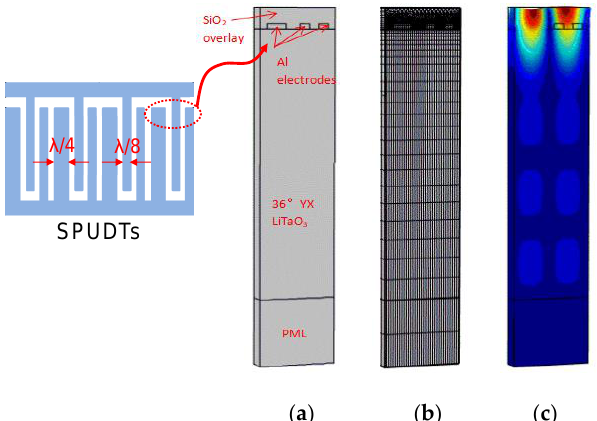
Figure 3. FEM analysis on Love wave devices ( a ) waveguide structure of SiO 2 /Al electrodes/36° YX LiTaO 3 ; ( b ) Meshing structure and ( c ) Love wave displacement profile.